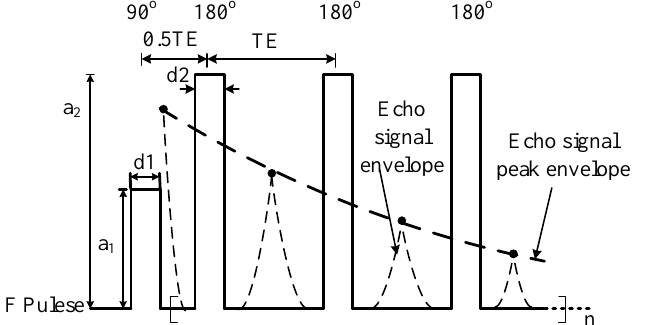
Figure 8. The pulse sequence of CPMG. Table 1. Parameters of CPMG